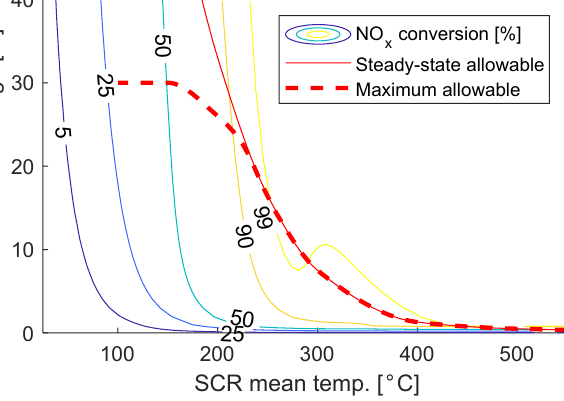
Figure 2. Ammonia storage reference as a function of temperature. The level curves also show NO x conversion at steady-state for the exhaust mass flow 0.15 kg/s, and engine out concentrations of 1800 PPM and 200 PPM for NO and NO 2 ,